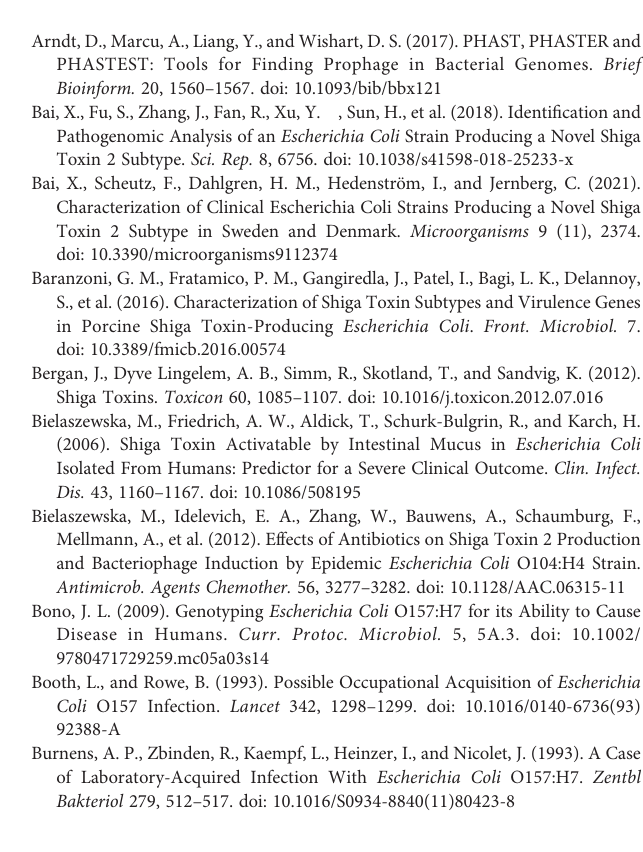
Supplementary Table 1 | PCR-primers and -cycling conditions. Supplementary Table 2 | Genomes and associated metadata of strains used in this study. Supplementary Table 3 | Virulence pro fi les of strains 7386 and 6535. Supplementary Table 4 | Catalogued core genome